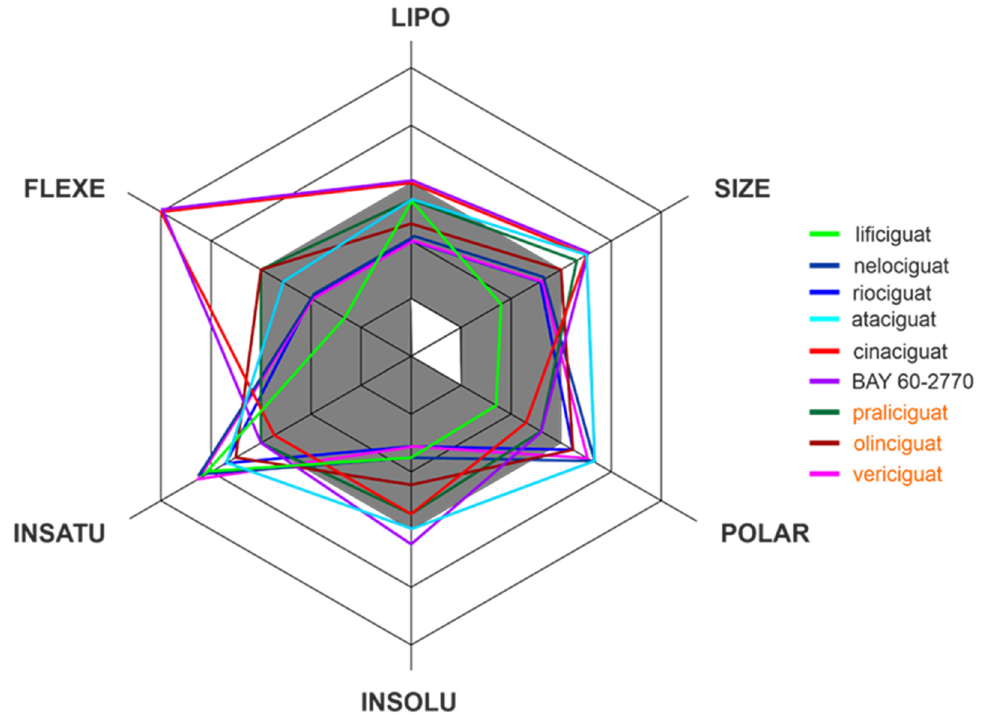
Figure 3. The bioavailability radar of the sCG activators/stimulators. The gray area represents the optimal range for each of the properties (lipophilicity: XLOGP3 between − 0.7 and +5.0, size: MW between 150 and 500 g/mol, polarity: TPSA between 20 and 130 Å2, solubility: log S no higher than 6, saturation: fraction of carbons in the sp3 hybridization no less than 0.25, and flexibility: no more than 9 rotatable bonds). The compounds names are indicated in the different font colors, i.e., black corresponds to sGC stimulators and orange corresponds to sGC activators.